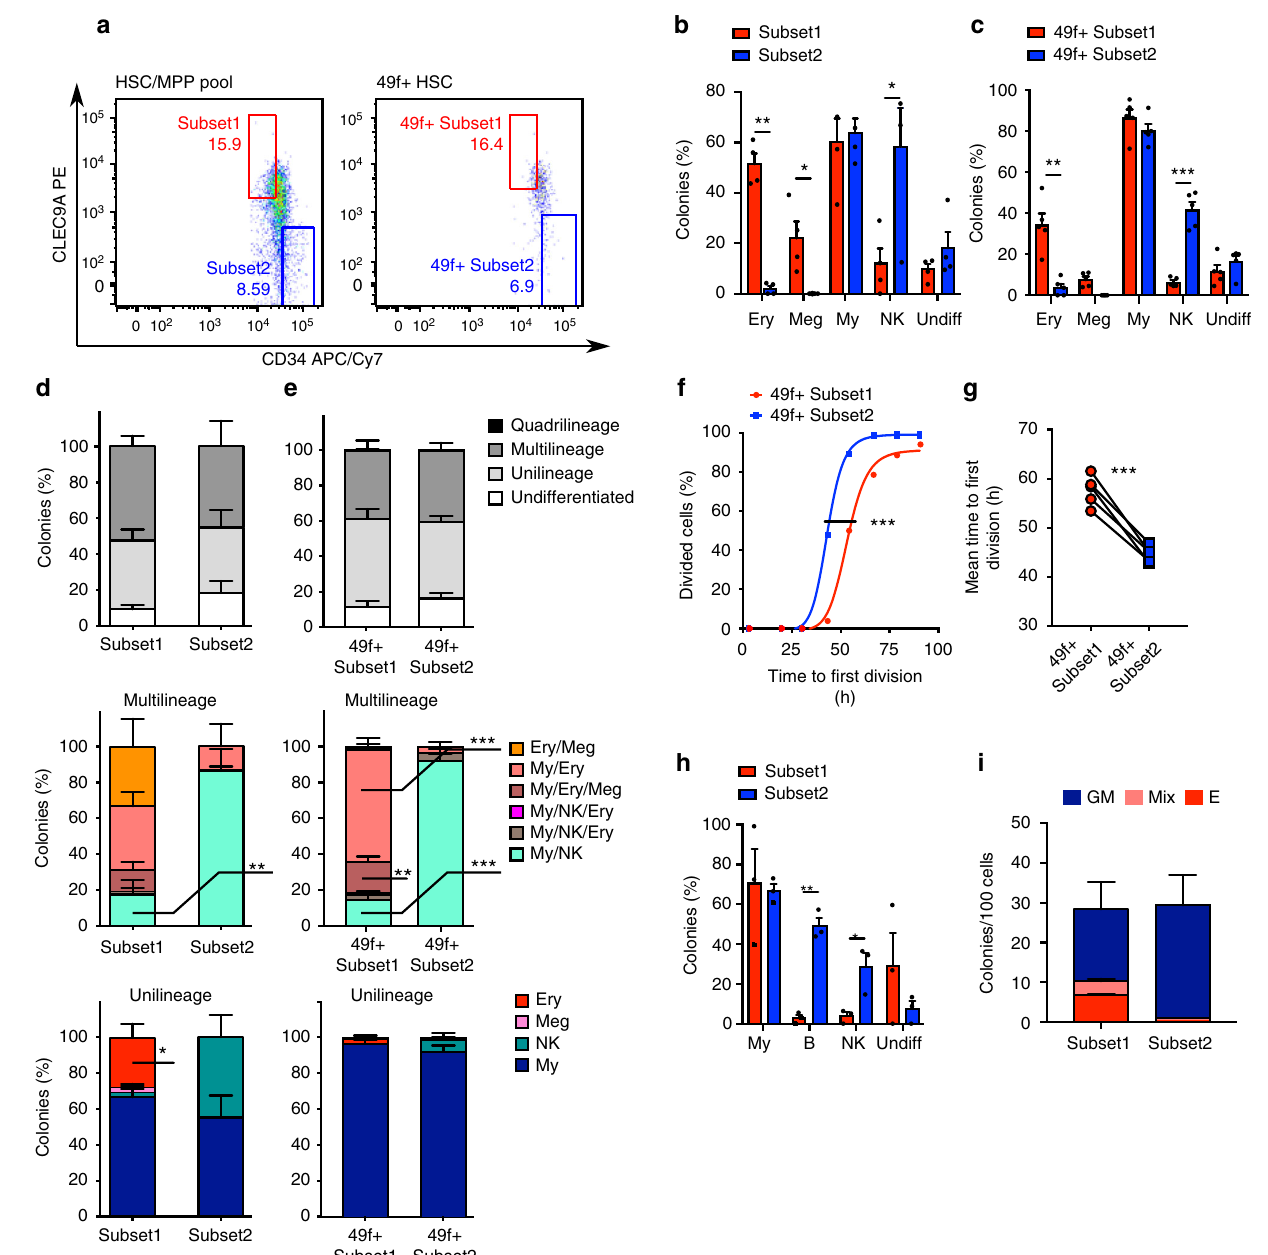
Fig. 2 Prospective puri fi cation of HSC/MPP pool and 49f + HSC cells with distinct in vitro differentiation capacity. a Representative examples of the gating strategy derived from in silico analysis used to isolate the indicated populations. b – e Single cells were plated in the same assay as in Fig. 1a – f. Percentage of colonies containing differentiated cells of the indicated lineages, generated by single Subset1 (red) or Subset2 cells (blue) ( b ) and by single 49f + Subset1 (red) or 49f + Subset2 cells (blue) ( c ). Percentage of colonies of the indicated types derived from Subset1 and Subset2 ( d ) and from 49f + Subset1 and 49f + Subset2 single cells ( e ). n = 4 independent CBs, n = 270 colonies from Subset1, n = 171 colonies from Subset2 ( b , d ). n = 5 independent CBs, n = 628 colonies from 49f + Subset1, n = 522 from 49f + Subset2 ( c , e ). Mean ± SEM is shown * p < 0.05, ** p < 0.01, *** p < 0.001 by two-sided paired t -test ( b – e ). f Representative example of cumulative fi rst division kinetics of 49f + Subset1 (red) and 49f + Subset2 (blue) single cells. Curves are a non-linear least squares ordinary fi t (non-log); *** p < 0.001 by extra sum of squares F -test. g Mean time to fi rst division of 49f + Subset1 (red) and 49f + Subset2 (blue) (EC 50 of non-linear fi t of cumulative fi rst division kinetics as in f ); n = 5 independent experiments each with an independent CB (with, respectively, 384, 384, 360, 150 and 192 single cells per experiment); *** p < 0.001 by two-sided paired t -test. h Cells were plated in an assay supporting differentiation of My, B and NK cells. Percentage of colonies generated by Subset1 (red) or Subset2 (blue) single cells and containing differentiated cells of the indicated lineages; mean ± SEM is shown, n = 3 independent CBs (Subset1 138 colonies, Subset2 142 colonies), * p < 0.05, ** p < 0.01 by two-sided paired t -test. i Number of colonies/100 cells from either Subset1 or Subset2 populations plated in a CFU assay. The type of colony: erythroid (E), granulocyte and myeloid (GM) or a combination of both (mix) is shown, ( n = 2 independent CBs); mean ± SEM is